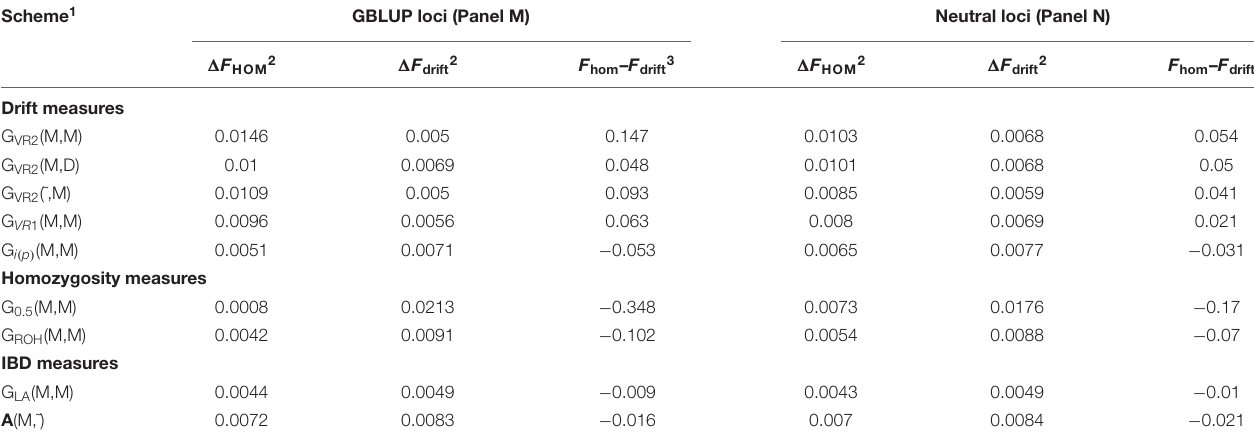
TABLE 2 | Rates of increase of homozygosity ( (cid:49) F hom ), drift ( (cid:49) F drift ), and the deviation F hom – F drift in generation 20 for different types of diversity measures for Panels M and N. Scheme 1